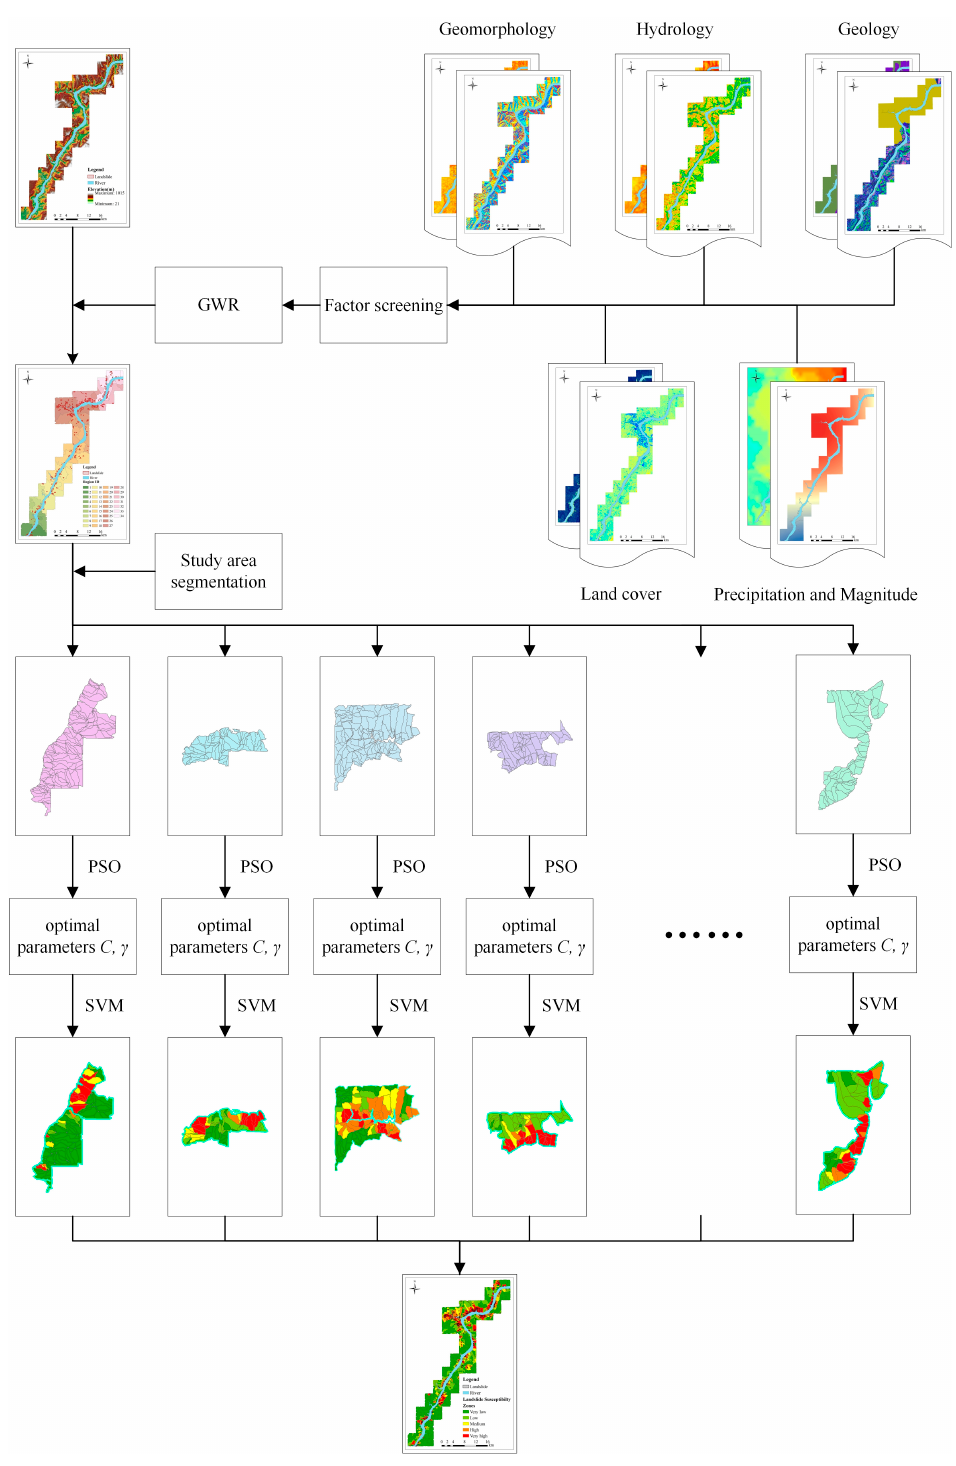
Figure 4. Flow-chart of our proposed